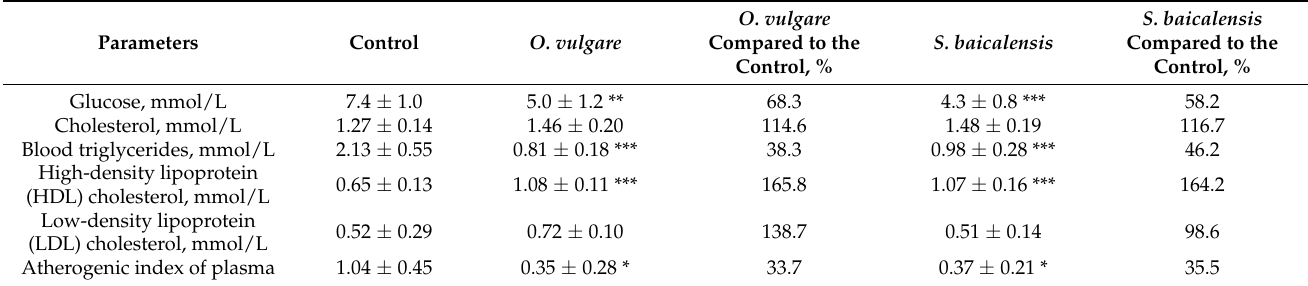
Table 3. Changes in the parameters of lipid and carbohydrate metabolism in the blood of male rats under effects of the addition of Origanum vulgare L. and Scutellaria baicalensis Georgi to their diet (x ± SD, n = 8, duration of experiment—30 days).